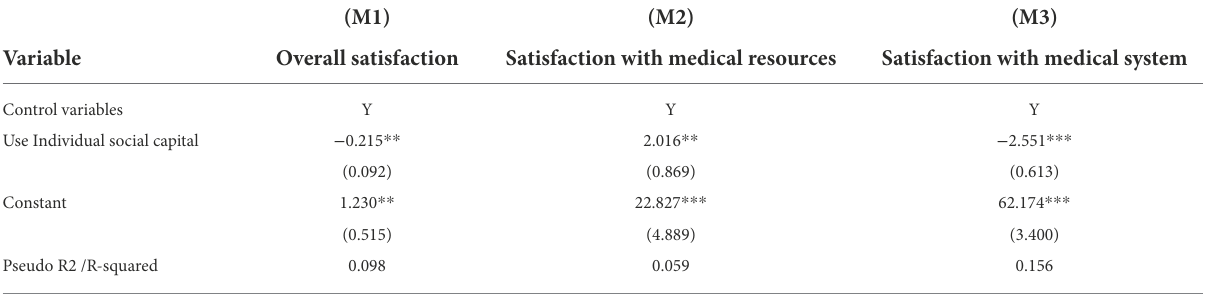
TABLE 4 Logistic and multiple linear regression of Individual social capital and RSMS ( N =